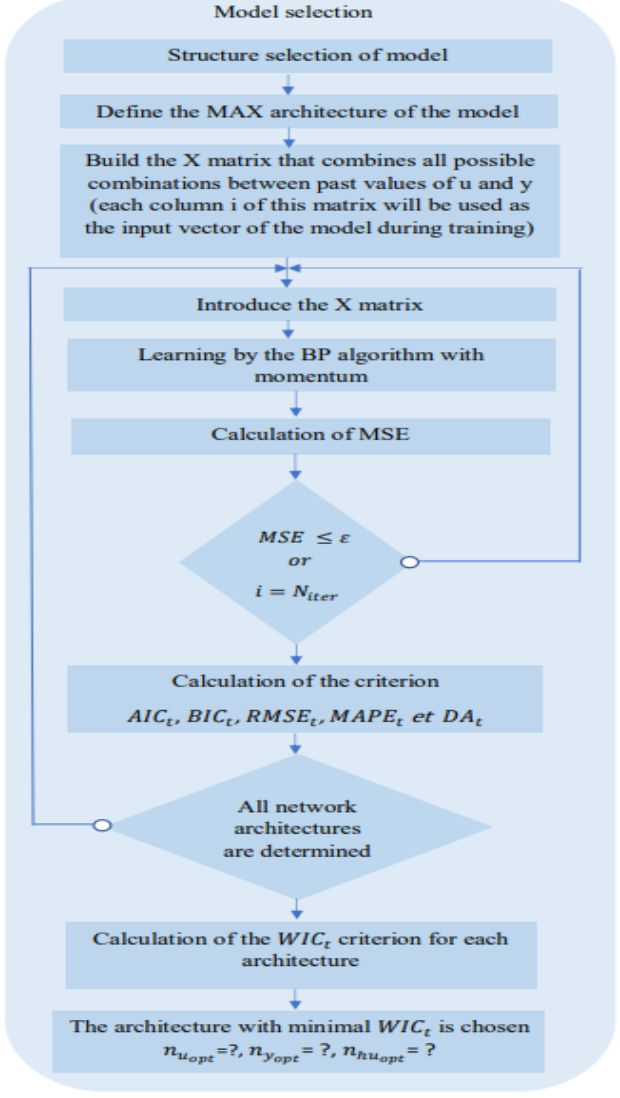
Figure 4. Flowchart of the optimal architecture selection strategy.